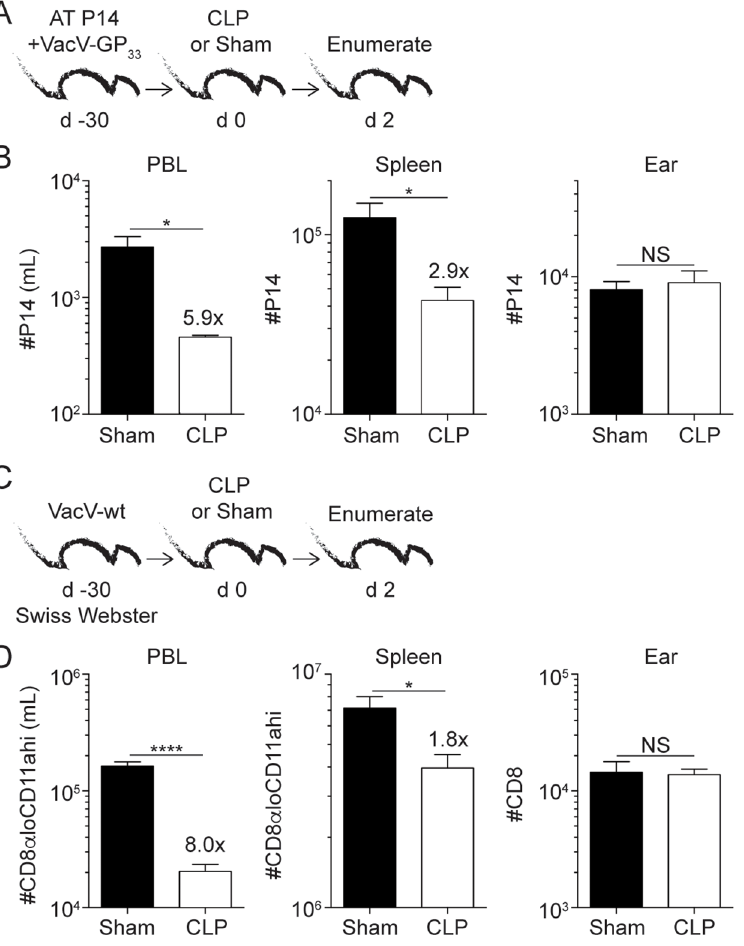
Fig 1. Sepsis reduces the number of CD8 T CIRCM to a greater extent than skin T RM of the same Ag- specificity. (A) Experimental Design. 5 x 10 3 na ï veP14 CD8 T cells (Thy1.1) were adoptivelytransferred into C57Bl/6recipients(Thy1.2) followedby VacV-GP 33 infectionof the left ear. After 30 days mice underwent CLP or sham surgery and two days later mice receivedintravascular injectionof CD45.2mAb. Tissues of interest were harvested three minutes later. (B) Enumeration of P14 T CIRCM in peripheralbloodand spleen and P14 skin T RM (CD45.2-CD103+) in the left ear two days after surgery. (C) Experimental Design. Swiss Webster outbredmice receivedwild type VacV infection of the left ear. After 30 days mice underwentCLP or sham surgery, and two days later tissues of interest were harvestedand cells enumerated.(D) Enumeration of Ag-experienced(CD8 α lo CD11a hi ) T CIRCM in peripheral bloodand spleenand CD8 skin T RM (CD45.2-CD103+) in the left ear two days after surgery. Data are representative of two independent experimentswith (A-B) 4 mice per group or (C-D) 7–9 mice per group. NS = not significant; * = p < 0.05; **** = p < 0.0001.Error bars represent the standarderror of the